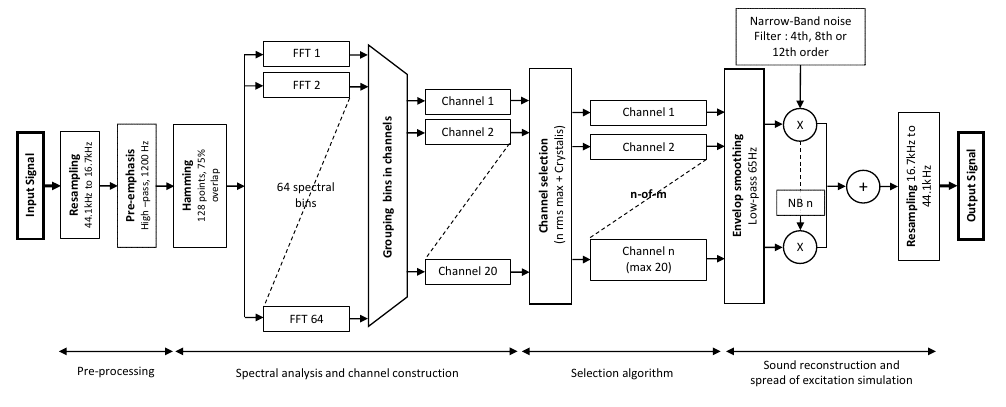
Figure 1. Block diagram of the CI simulation/vocoder. Table 1. Centre and cutoff frequencies of the vocoder. Number of bins (FFT coefficients) per